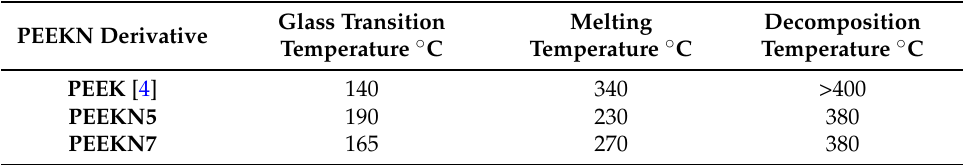
Table 1. Glass transition, melting and decomposition temperature of the synthetized polymers. PEEK values are given for comparison.